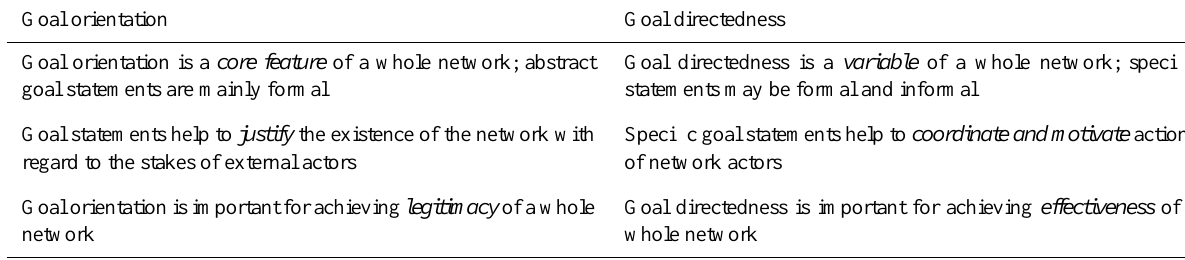
Table 1. Comparing goal orientation and goal directedness of whole